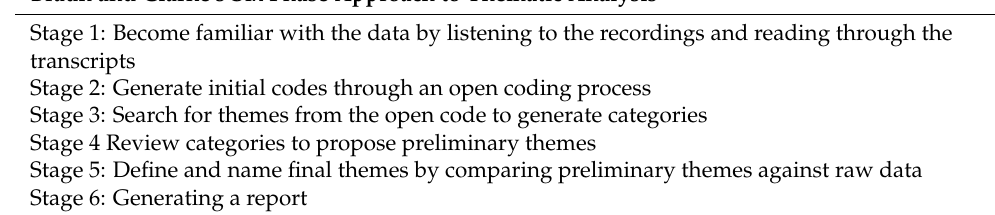
Table 2. Stages of Thematic Analysis. Braun and Clarke’s Six Phase Approach to Thematic